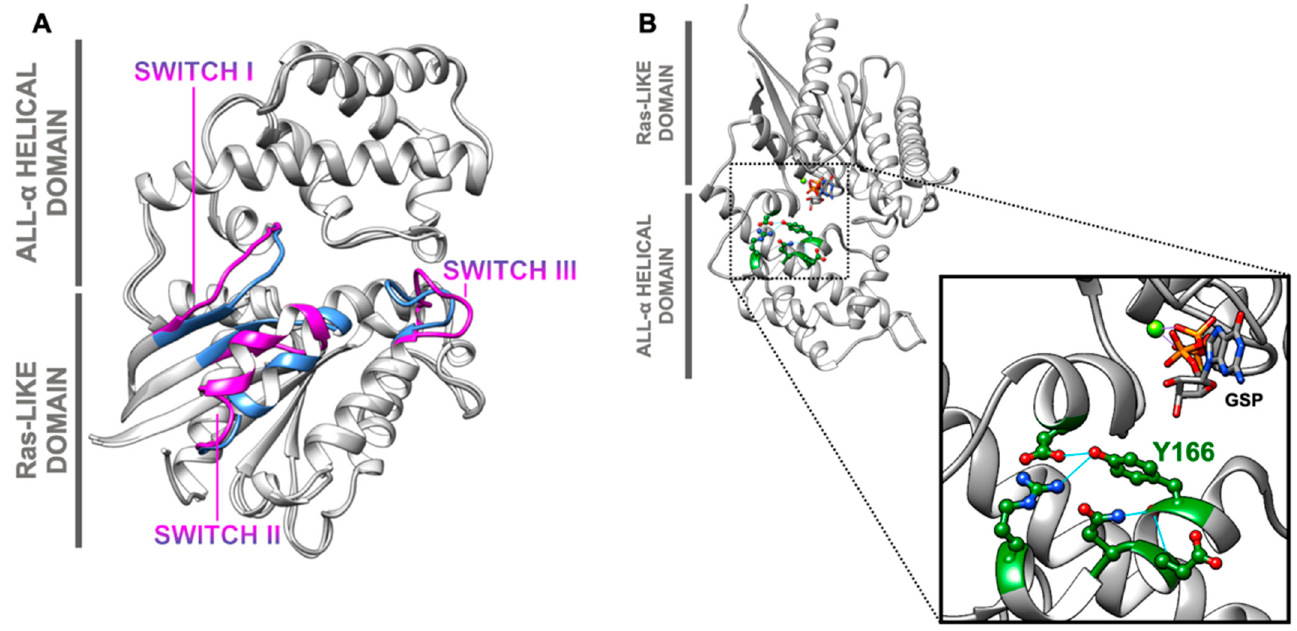
Figure 3. Switching mechanism of G α . ( A ) The animal G α activation mechanism. Transducin alpha.GDP (grey and magenta, PDB 1TAG) and transducin alpha.GTP (grey and light blue, PDB 1TND) from Bos taurus were selected in order to show nucleotide-induced conformational change in animals. Structures were overlapped, and switch regions of both states were colored in pink and blue, as indicated. Adapted from [67]. ( B ) The plant G α “phosphoswitch” region. AtGPA1 is phosphorylated at tyrosine 166 in order to affect AtRGS1 interaction and its accelerated GTPase cycle. The crystal structure of AtGPA1 (PDB 2XTZ) is represented in grey with forest green highlights. Tyr166 is at the interface of the two conserved domains and forms hydrogen bonds (cyan) with neighbor residues (balls and sticks). A GTP molecule with Mg 2+ is near this residue, and they are represented as sticks and as a light green sphere, respectively. Adapted from [68].